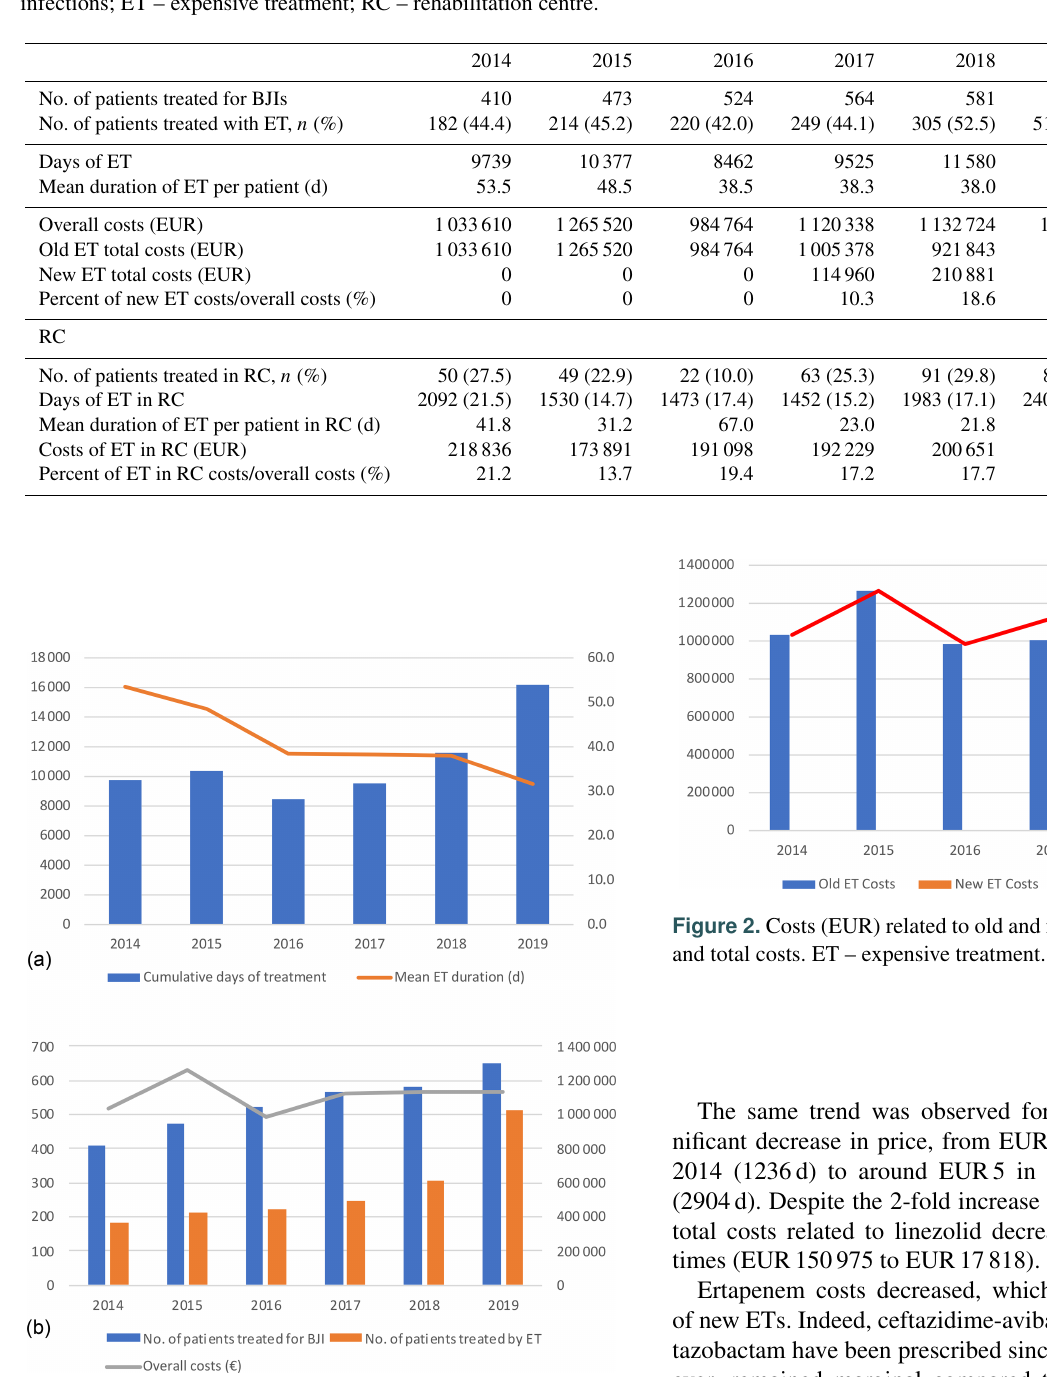
Table 3. Number of patients treated in our referral centre and the duration and costs related to expensive treatment. BJIs – bone and joint infections; ET – expensive treatment; RC – rehabilitation centre.